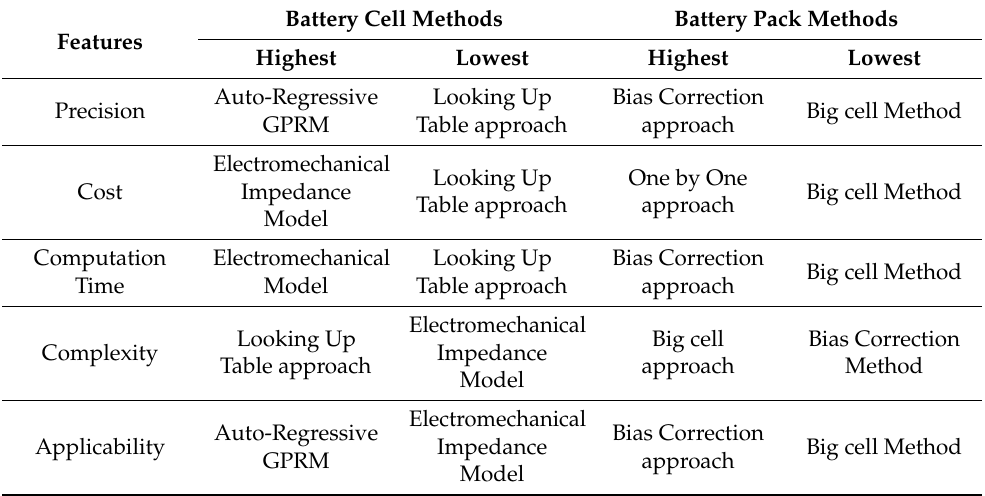
Table 1. Comparison of SOC estimation methods for battery cells and battery pack